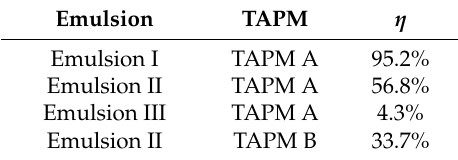
Figure 7. Droplet size distributions of I, II, and III emulsions.